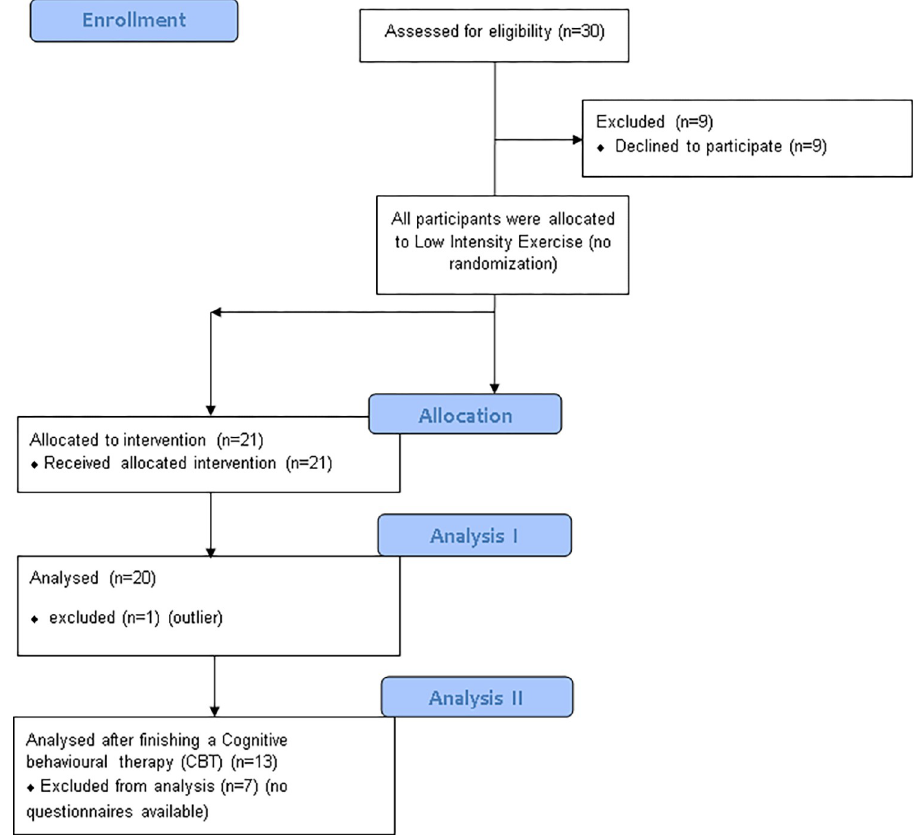
Fig 1. Flow chart showing study enrollment, allocation and number of patients